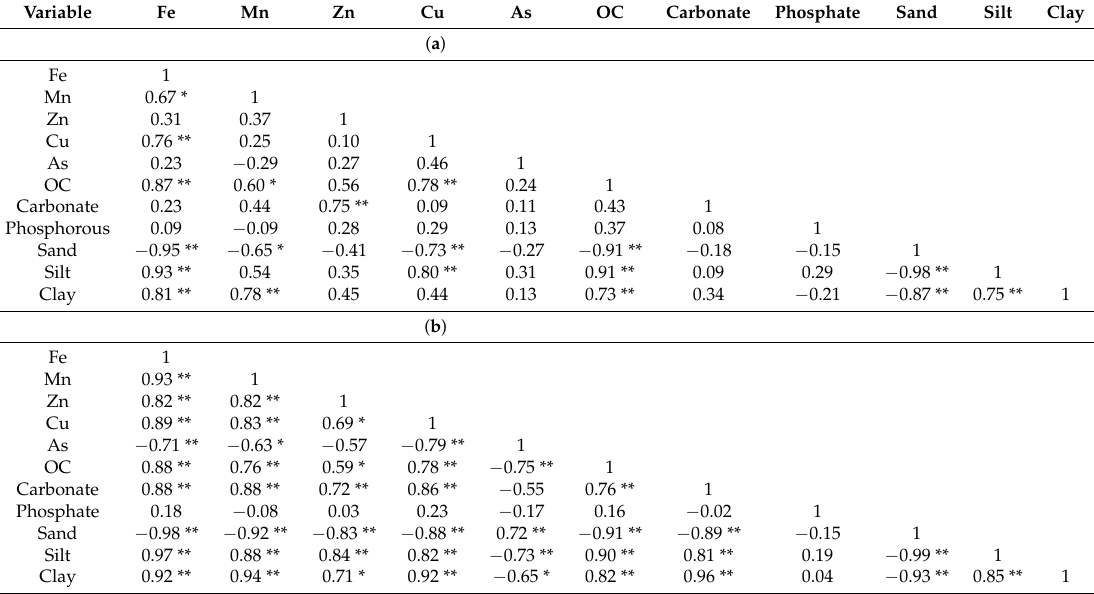
Table 3. Correlation among As and other parameters ( a ) Rigni Chhapra ( b ) Chaube Chhapra. Variable Fe Mn Zn Cu As OC Carbonate Phosphate Sand Silt